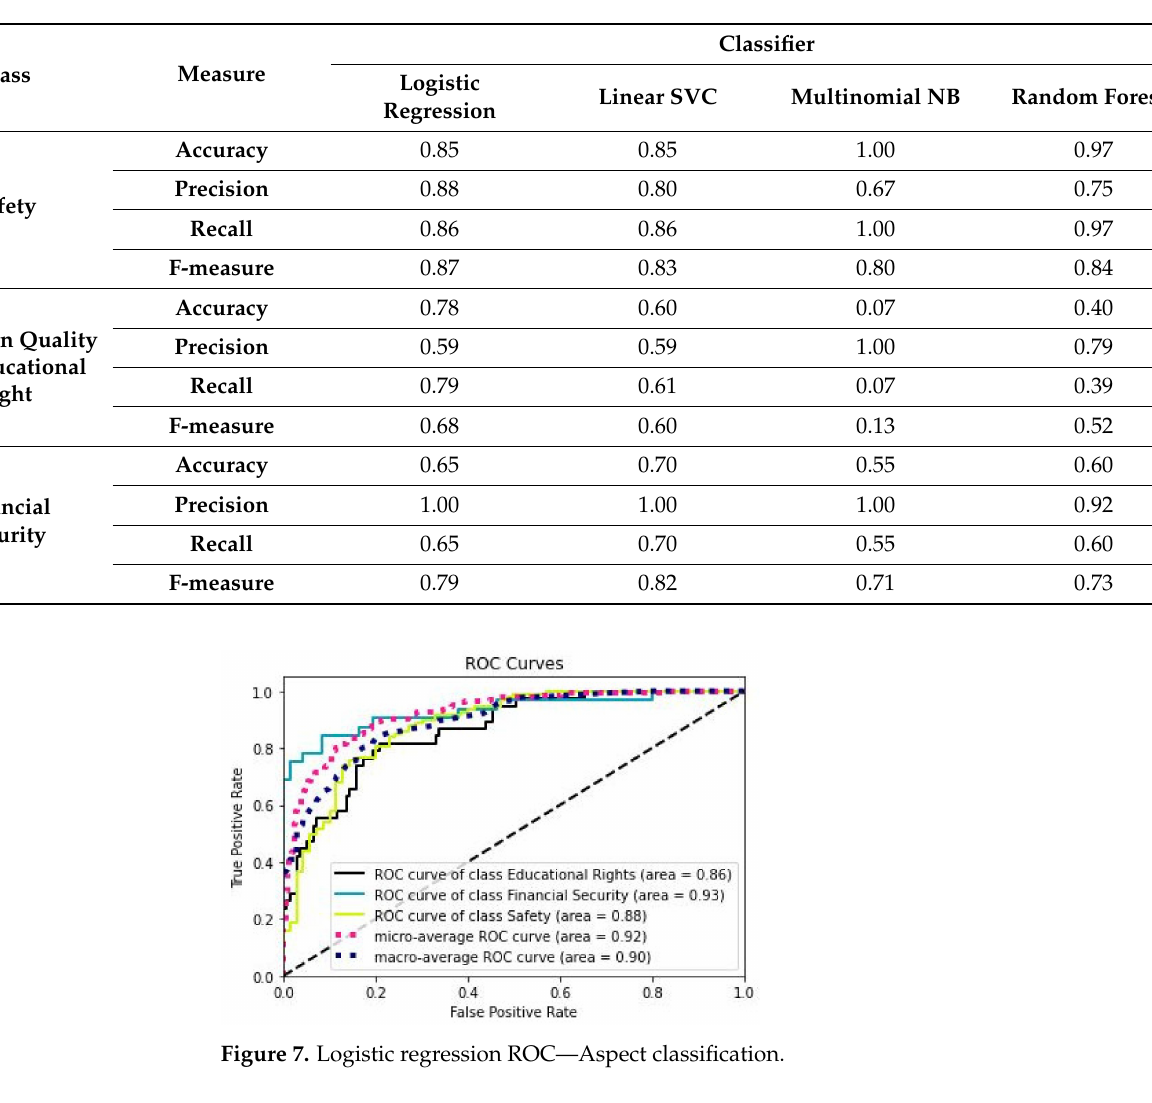
Table 12. ABSA classification results per-class.